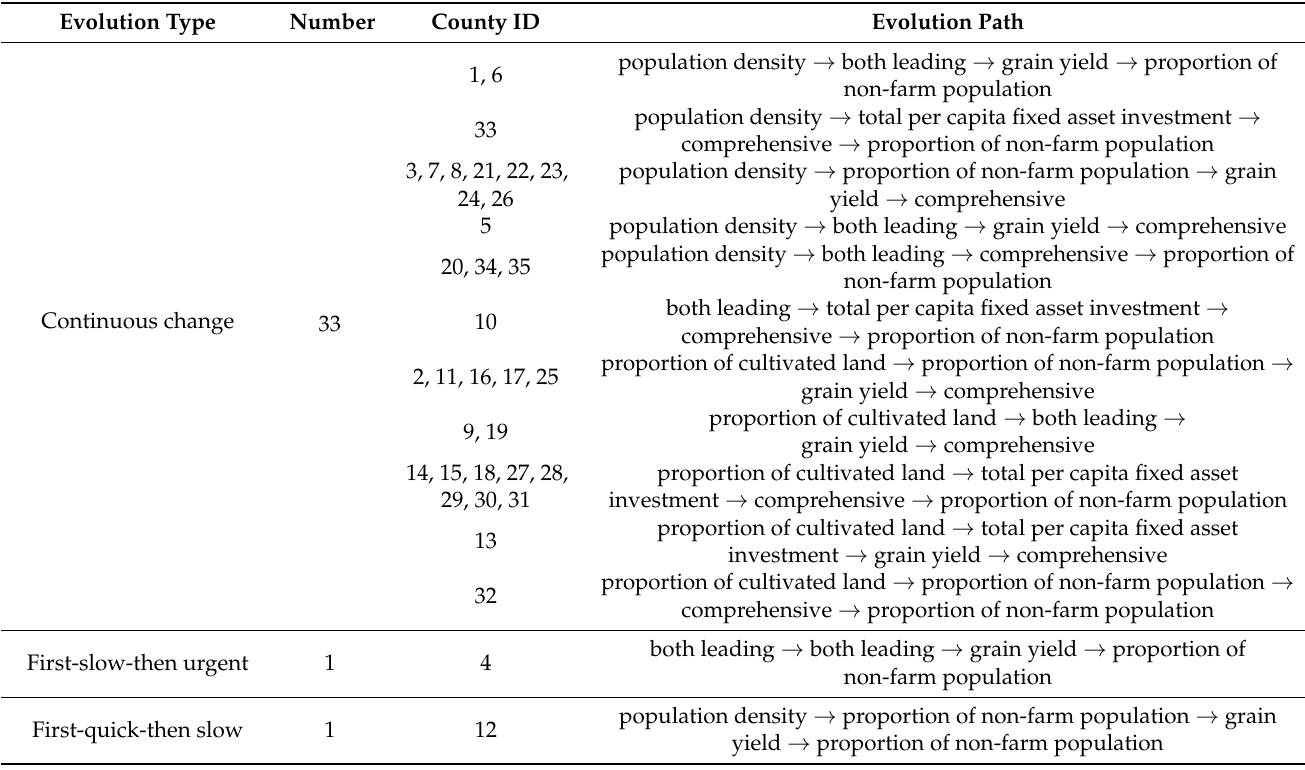
Table 5. Driving force evolutions in the Chengdu metropolitan